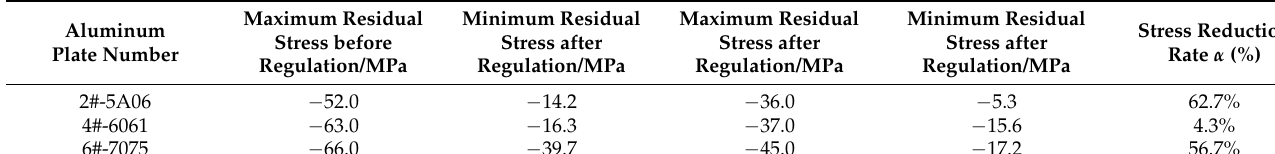
Table 5. Comparison of residual stress and deformation of milling 1 mm before and after ultrasonic control.